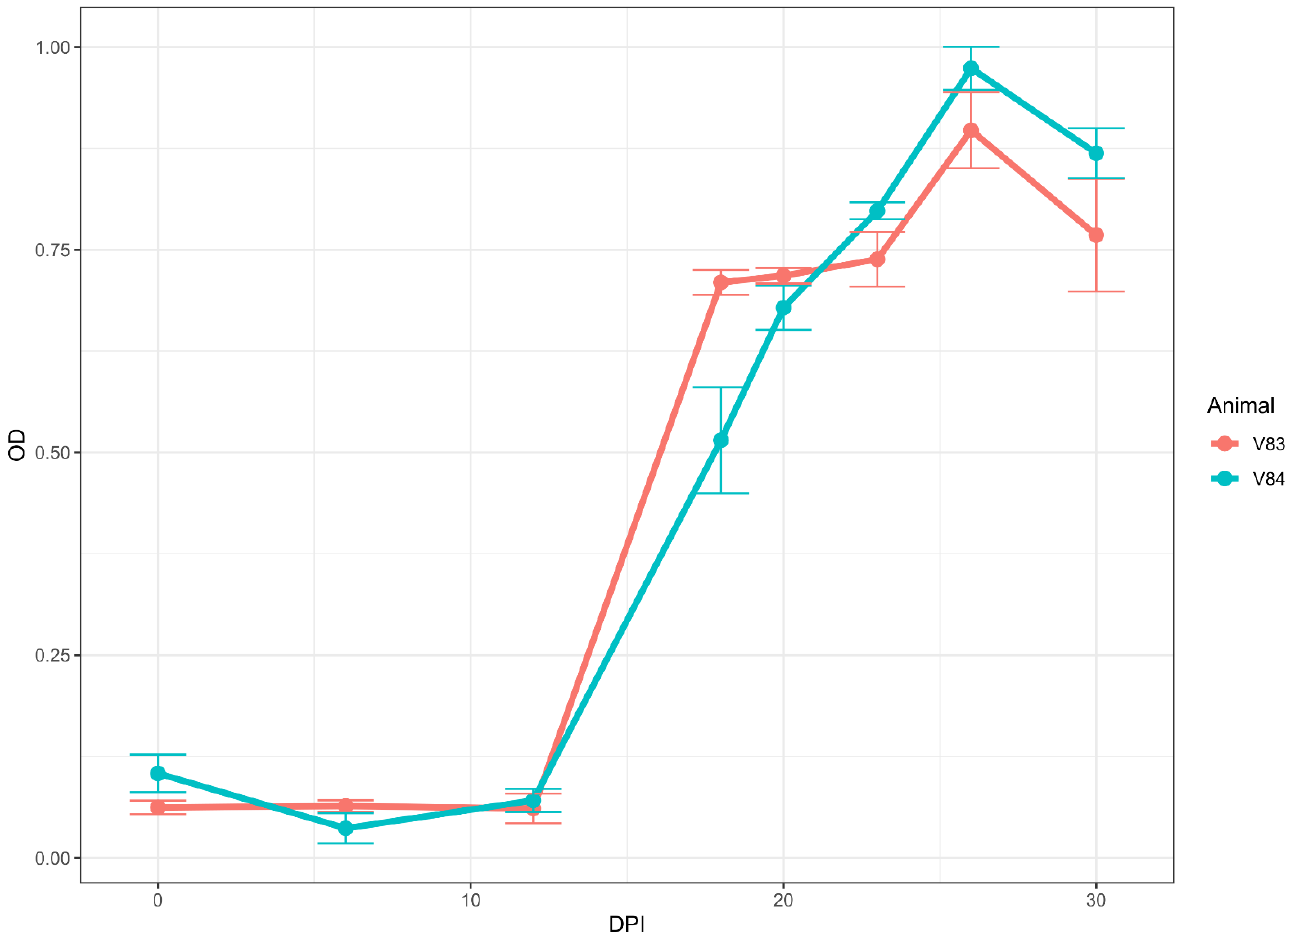
Figure 4. Immunoreactivity (seroconversion) of serum samples from cattle experimentally infected with virulent LSD isolate. (A) Two cattle were inoculated, and samples were collected at 0, 6, 12, 18, 20, 23, 26, and 30 days post-infection (DPI). Note the rise in immunoreactivity between 12 and 18 DPI for cattle. The data represent the average of two runs in duplicate + standard deviation.